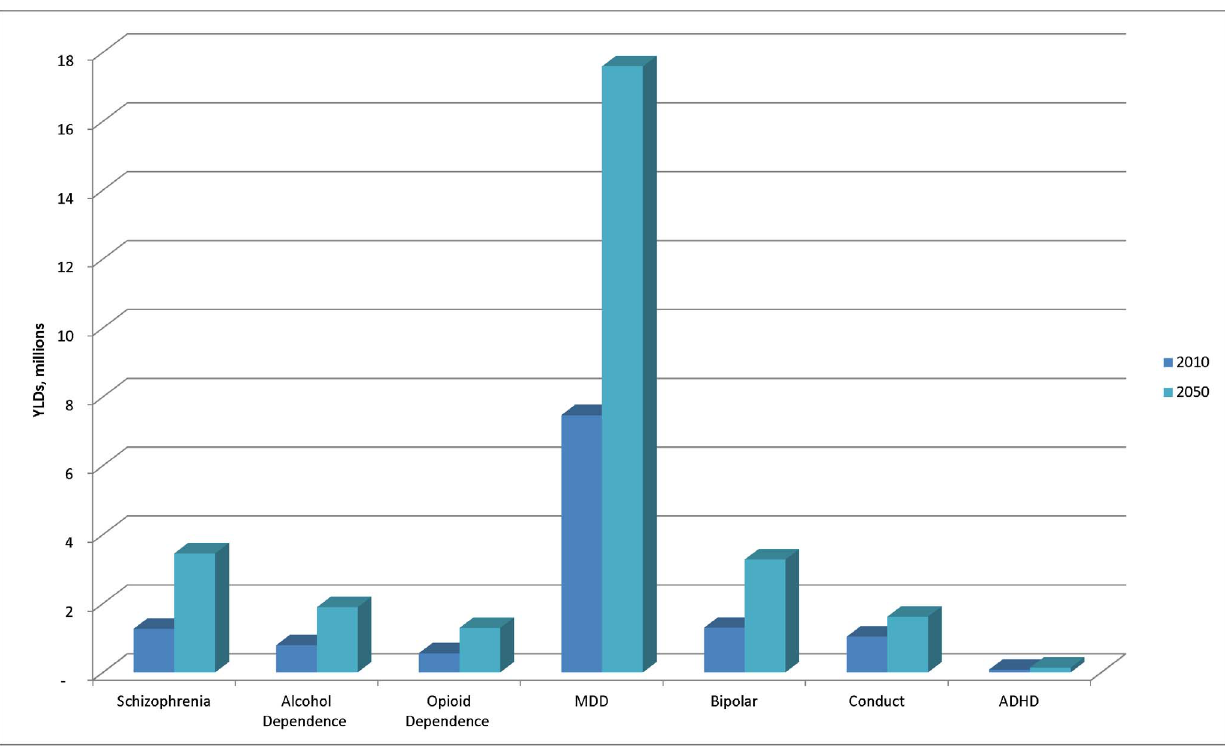
Figure 3. Disability burden for individual mental and substance use disorders, 2010 to 2050.